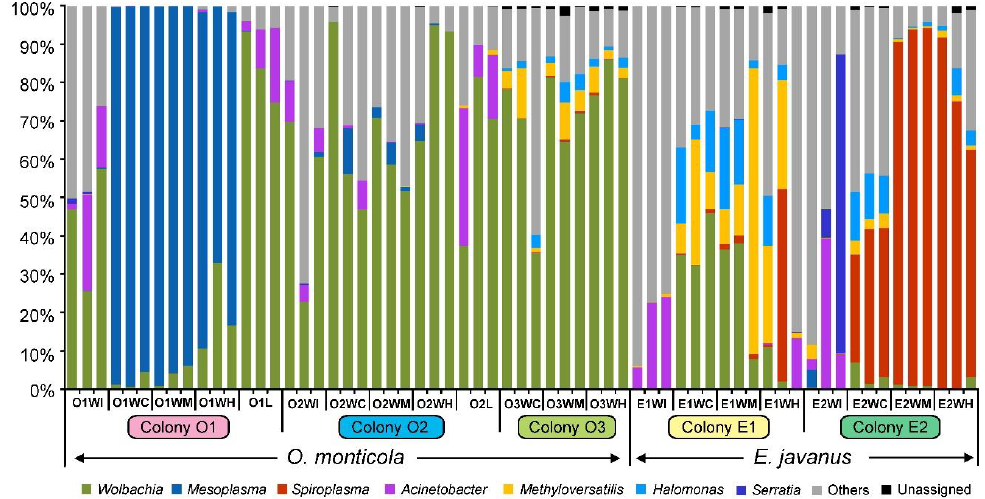
Figure 2. Bacterial communities of two ponerine ant species and their colonies at the genus level. O1, O2, and O3, three colonies of O. monticola ; E1 and E2, two colonies of E. javanus . WI, the infrabuccal pockets of workers; WC, the crop of workers; WM, the midguts of workers; WH, the hindguts of workers; L, larvae. Sample names are listed in Table 1.